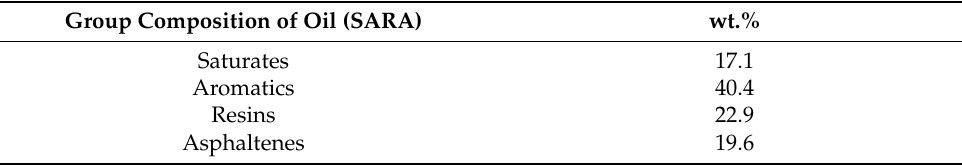
Table 2. SARA analysis of Boca de Jaruco extra-heavy oil.